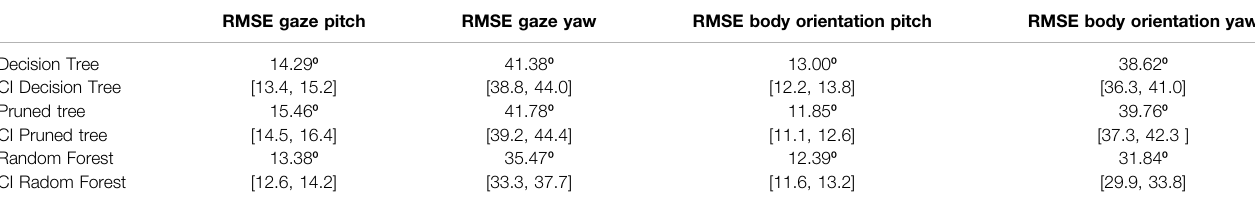
TABLE3| RMSE(indegrees)ofthebestestimatorsusingdecisiontrees,prunedtrees,andrandomforestalgorithmsforgazeandforbodyorientationwiththetestdata,and the respective 95% Con fi dence Intervals (CI). RMSE gaze pitch RMSE gaze yaw RMSE body orientation pitch RMSE body orientation